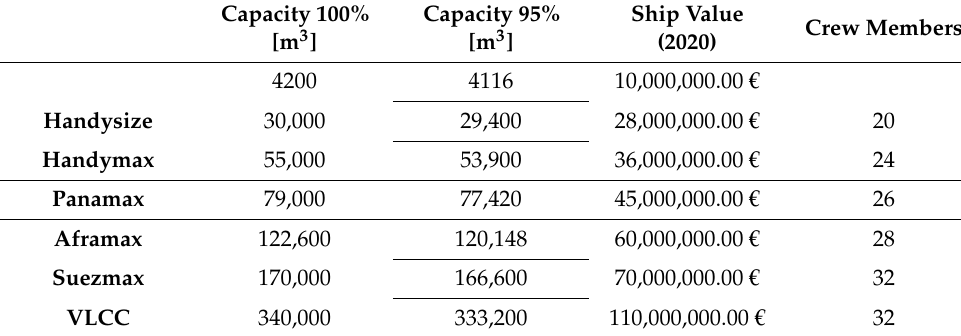
Table 3. Ship characteristics divided on bands.